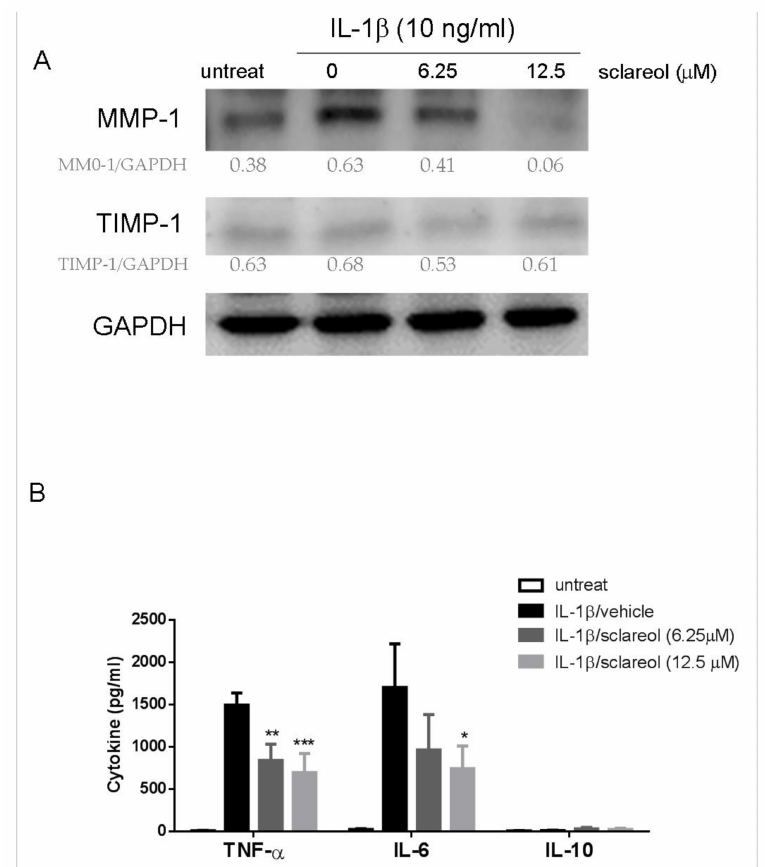
Figure 6. Effect of sclareol on IL-1 β -induced production of matrix metalloproteinases (MMPs) and cytokines in SW982 cells. SW982 cells were stimulated with 10 ng/mL IL-1 β with or without for sclareol for 72 h. ( A ) Expressions of MMP-1 and tissue inhibitors of metalloproteinase (TIMP)-1 in whole cell lysates were determined by Western blot with indicated antibodies. Glyceraldehyde 3-phosphate dehydrogenase (GAPDH) was used as a loading control, the normalized values (mean ± SD) compared to GAPDH were estimated by Image J software, and the normalized values were attached to each photographic band in the images. ( B ) The cytokine levels in culture supernatant were examined by ELISA. Bar graphs represent the mean ± SD of triplicate tests. * p < 0.05, ** p < 0.01, and *** p < 0.001 versus vehicle treated DMSO group. The data are representative of three independent experiments with similar